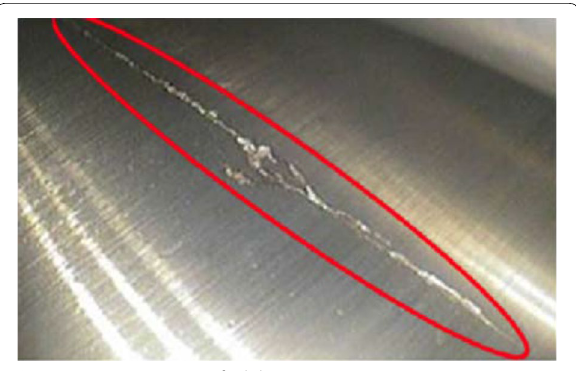
Figure 16 Inner raceway fault